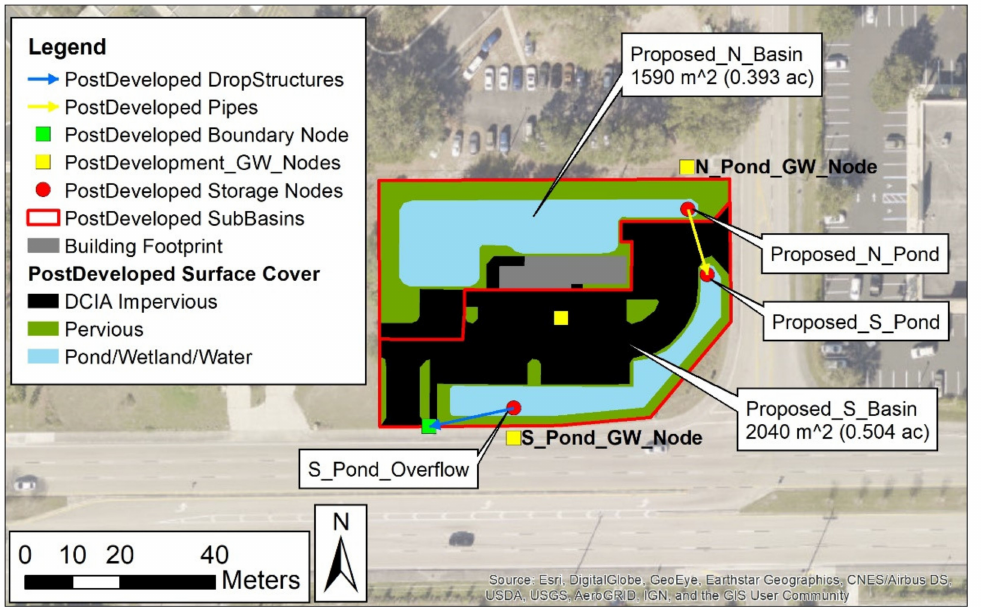
Figure 7. Post-development subbasins, storage/groundwater nodes, and hydraulic connections.